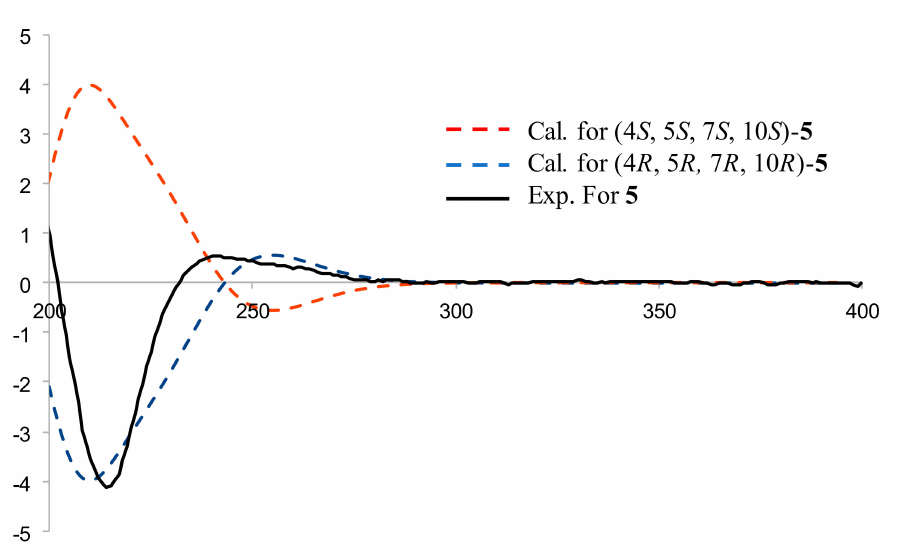
Figure 13. Comparison of the calculated ECD spectrum for (4 R , 5 R , 7 R , 10 R )- 5 at B3LYP/6-31G(d) level with the experimental spectrum of 5 in MeOH. σ = 0.3 eV, shift = − 20